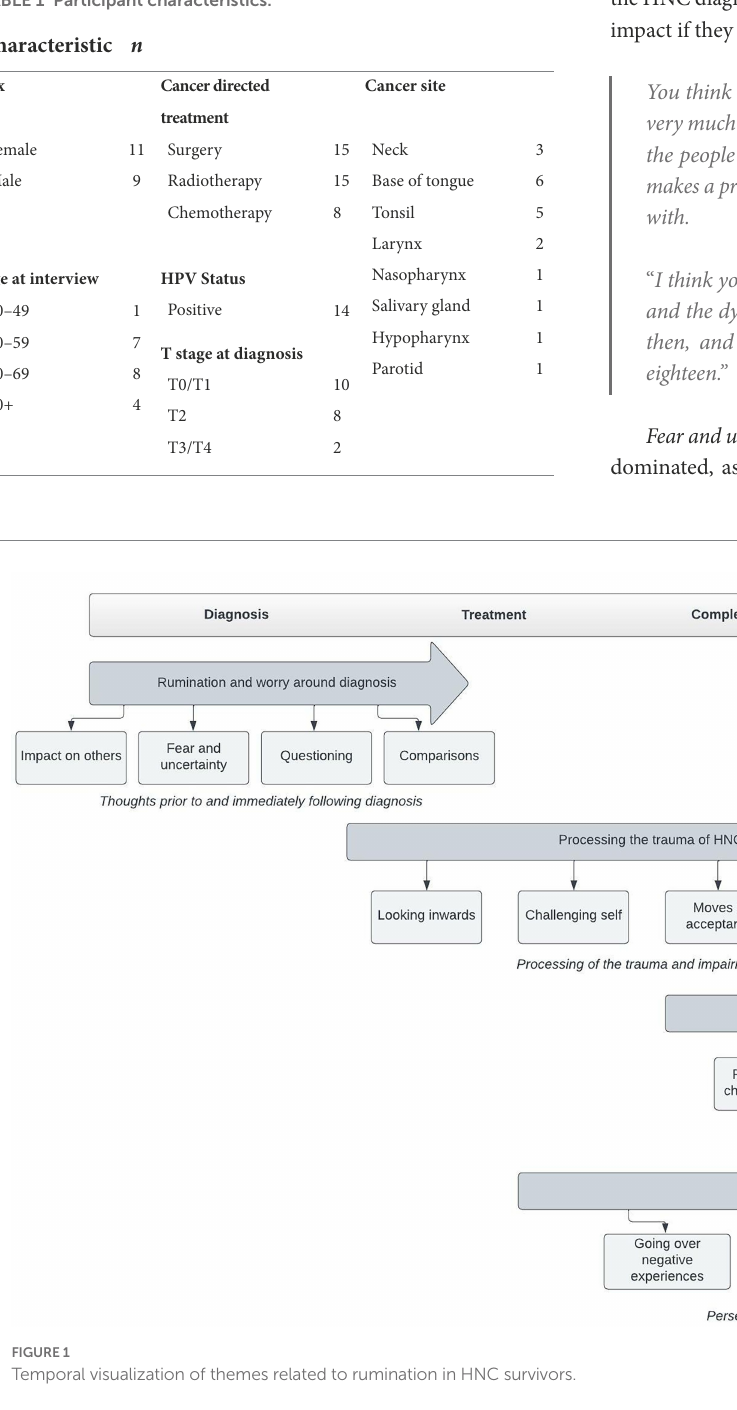
TABLE 1 Participant